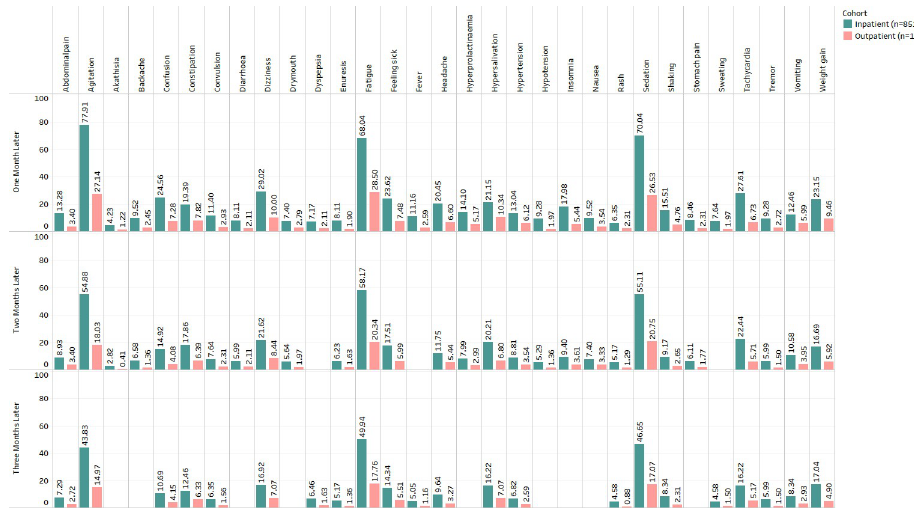
Fig 3. Frequency distribution of statistically significant ADRs (after Bonferroni p-value adjustment) from the combined analysis in hospital admission for three months after starting the drug Clozapine.